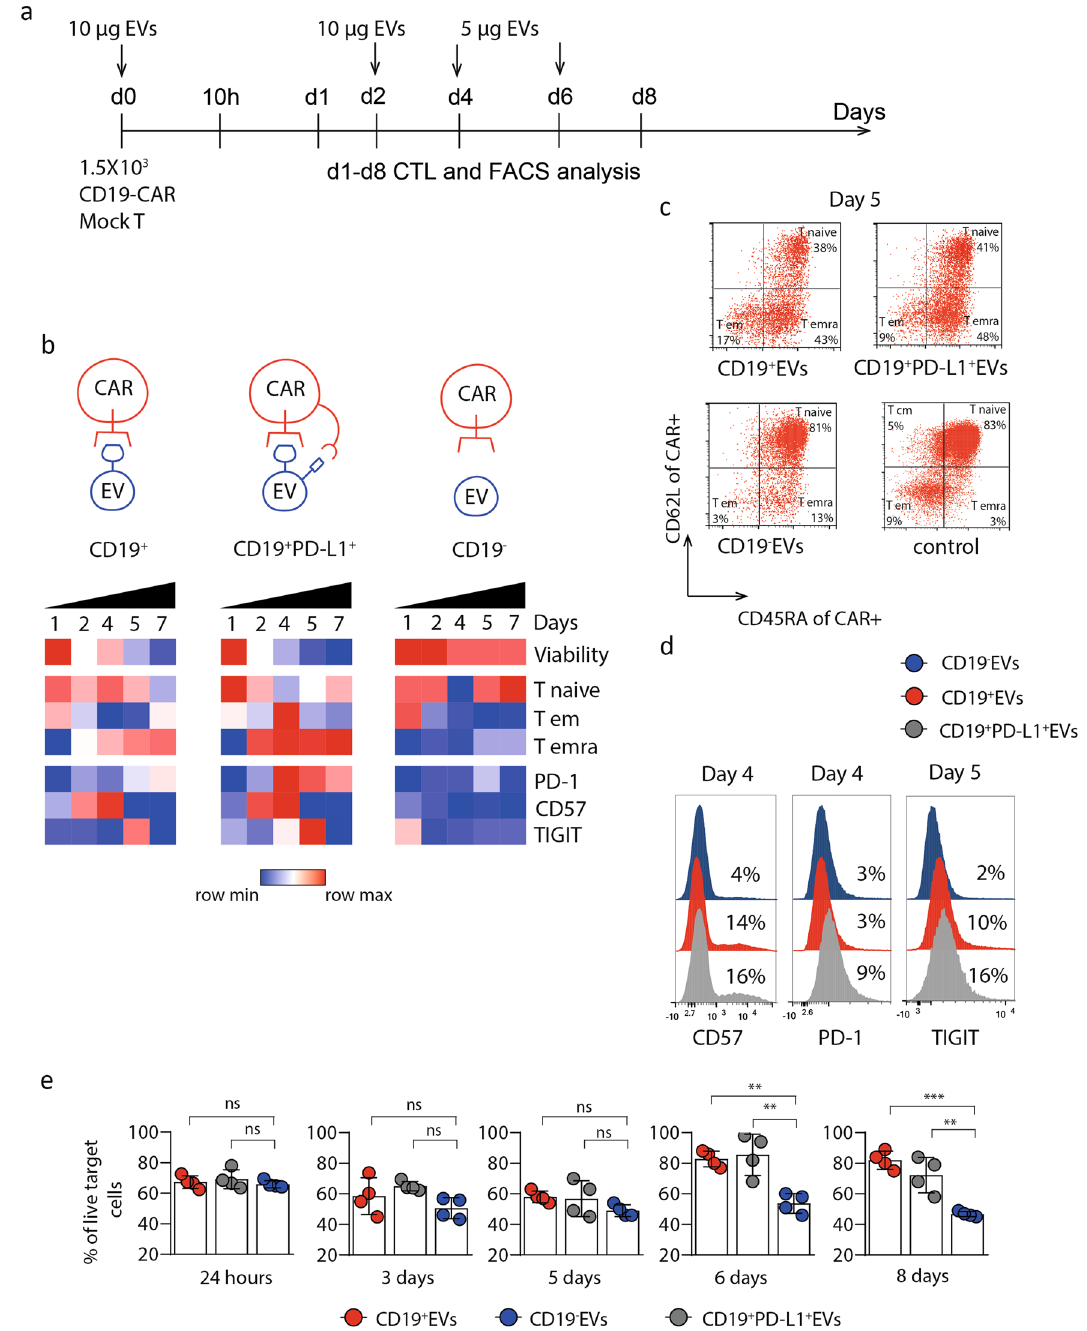
Figure 4. CD19 + EVs accelerate exhaustion and impair CD19-CAR T cells’ killing activity. A Experimental timeline. B Changes in viability and surface phenotype of CAR T cells cultured in presence of CD19 + , CD19 − or CD19 + PD-L1 + EVs and analyzed daily for 7 days. Data were normalized against T cells treated with corresponding EVs and presented as heat map of the mean of two experimental replicates from two independent experiments. C Representative histograms show the difference in proportion of CAR T cells expressing markers of functional exhaustion: CD57 (left), PD-1 (center), TIGIT (right). CAR T cells stained for corresponding markers were analyzed by flow cytometry on days 4–5. D Analysis of differentiation state of CAR-positive cells cultivated for 5 days in the presence of EVs. CD19-CAR T cells were stained with anti-CD62L and anti-CD45RA mAbs and CD19-FITC conjugate, analyzed by flow cytometry, and plotted as two-dimensional dot plots. CAR T cells incubated for 5 days in the absence of EVs served as negative control. E In vitro killing activity at different time points indicated in Fig. 3A of CD19-CAR T-cells cultured for 20 h with Nalm-6 cells at 1:16 E:T ratio in the presence of CD19 + , CD19 − , CD19 + PDL-1 + EVs or without EVs. Data are presented as the mean ± SD of four experimental replicates from at least two independent experiments. Statistical analysis was performed using one-way ANOVA with Tukey’s multiple comparison